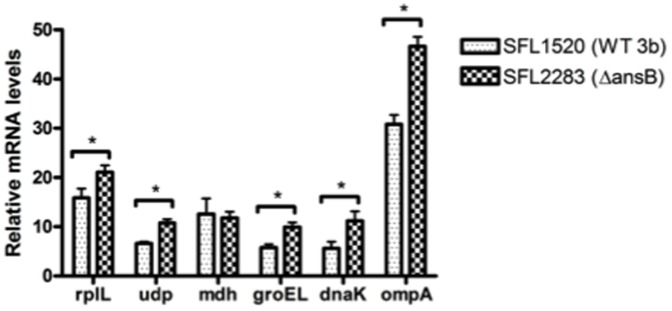
Reverse transcription quantitative PCR (qRT-PCR) analysis to confirm two dimensional differential in-gel electrophoresis (DIGE) analysis.Transcript levels of proteins identified by DIGE analysis, rplL, udp, mdh, groEL, dnaK and ompA, were measured in ΔansB (SFL2283) and wild type S. flexneri serotype 3b (SFL1520) and expressed as a ratio of the ansB mutation-induced levels and the basal wild type levels. Data represent the means of three independent biological repeats, each replicate measured in triplicate and normalized to the control gene hisG. Asterisks indicate statistically significant differences calculated using unpaired Student's t-test (p<0.05).